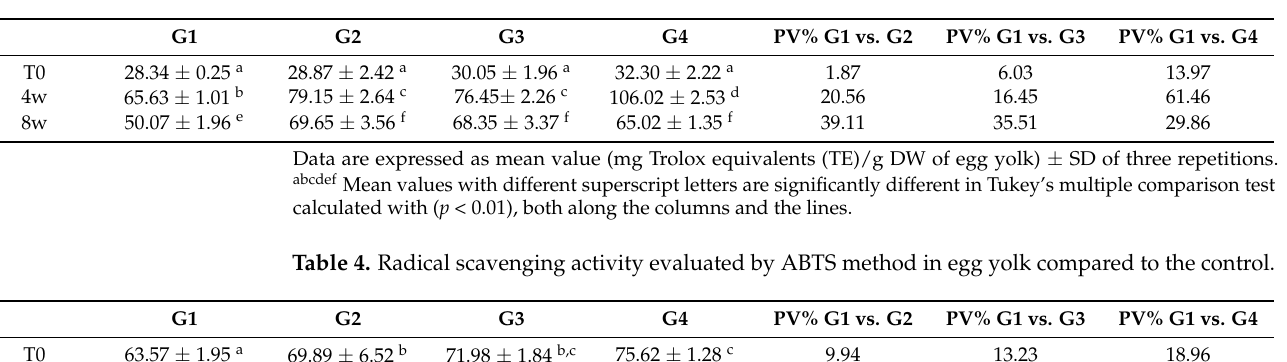
( p < 0.01), both along the columns and the lines. Table 3. Radical scavenging activity evaluated by DPPH method in egg yolk in respect to the control.